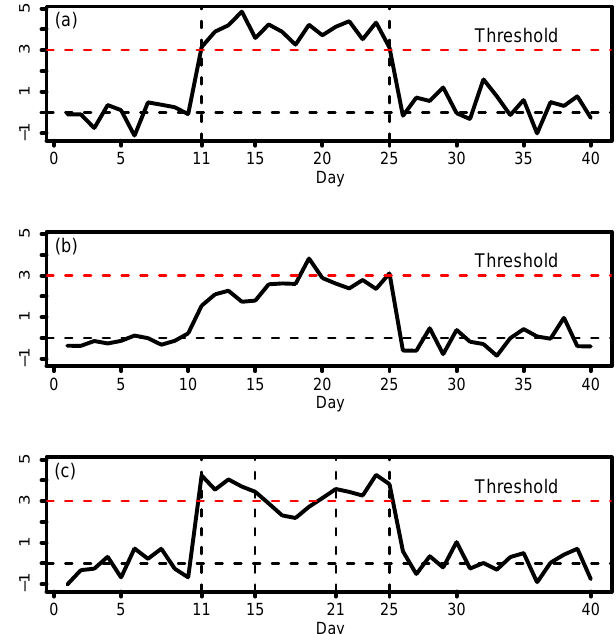
Figure 2. Schematical illustration of our approach (temperature anomaly on the y axis): (a) model detects correctly one heat pe- riod above the threshold, (b) model underestimates the number of heat periods, and (c) model overestimates the number of heat peri- ods (for details see text).